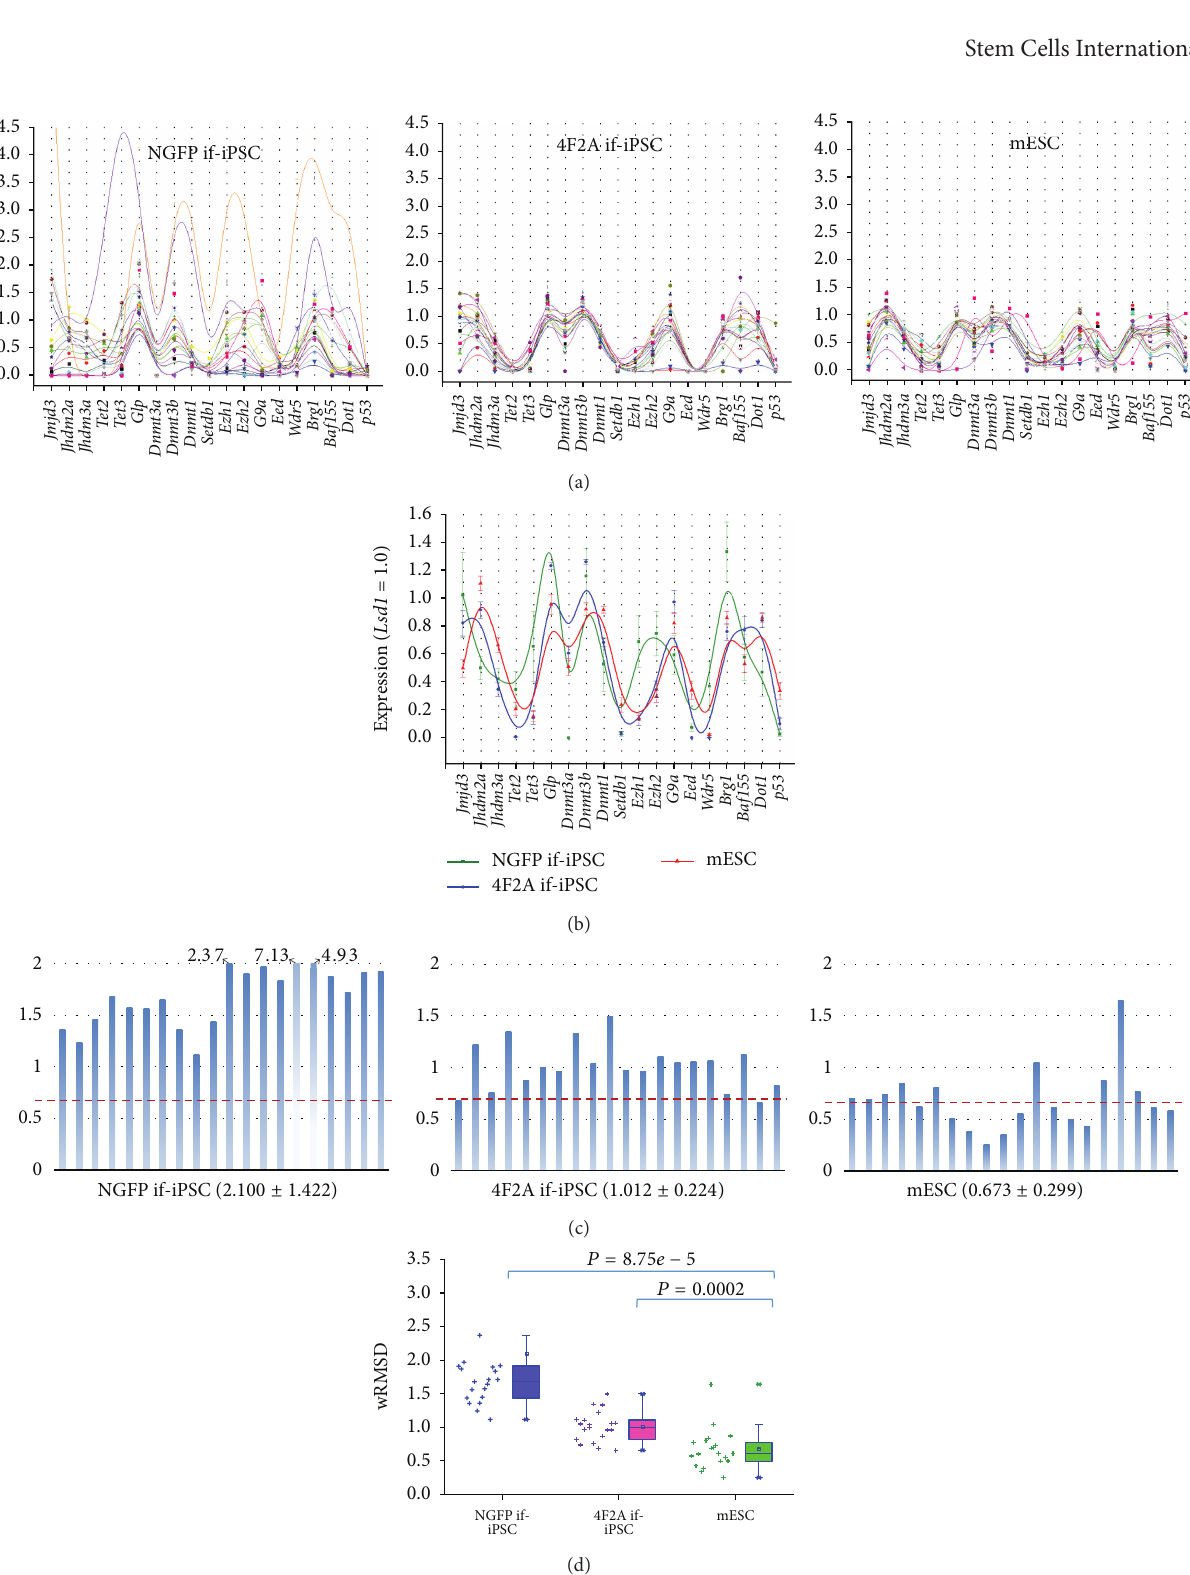
Figure 5: wRMSD analysis of gene expression profiles of reprogramming-related genes between 4F2A if-iPSCs and NGFP if-iPSCs. (a) GEPs of reprogramming-related genes in individual colonies. Spline-type plots are shown where individual lines in different colors denote the expression profiles of reprogramming-related genes in individual colonies. (b) Mean GEPs of individual colony groups. Error bars, standard error. (c) Relative wRMSD. It is obtained by assessing the deviations of the gene expression in each NGFP if-iPSC and 4F2A if-iPSC colony from the mean GEP of the mESC group. A reference line in red on each panel denotes the mean wRMSD in the mESC colony group. (d) Statistical difference between the groups. The 𝑃 values are indicated above ( 𝑡 -test). The wRMSDs of individual colonies are shown as crosses on the left of each box plot. The wRMSD range is set to 0.0–2.0 for a group-to-group comparison, and those wRMSDs beyond 2.0 are denoted above. The mean values are indicated in the boxes (circles). Box whiskers indicate the range from 5% to